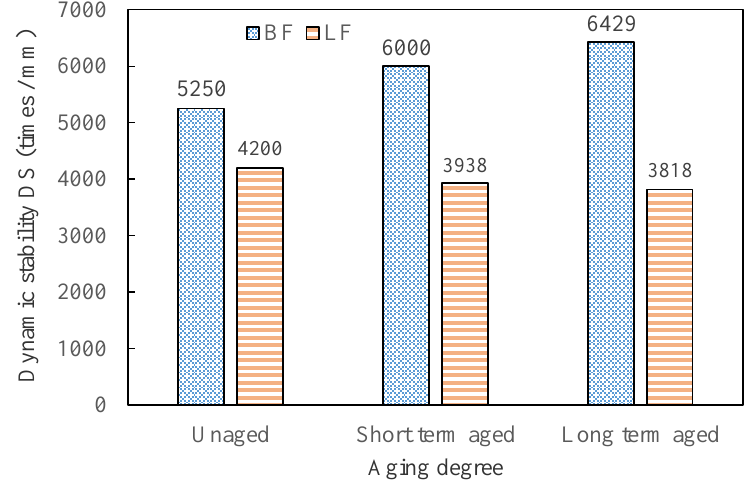
Figure 4. Results of dynamic stability.